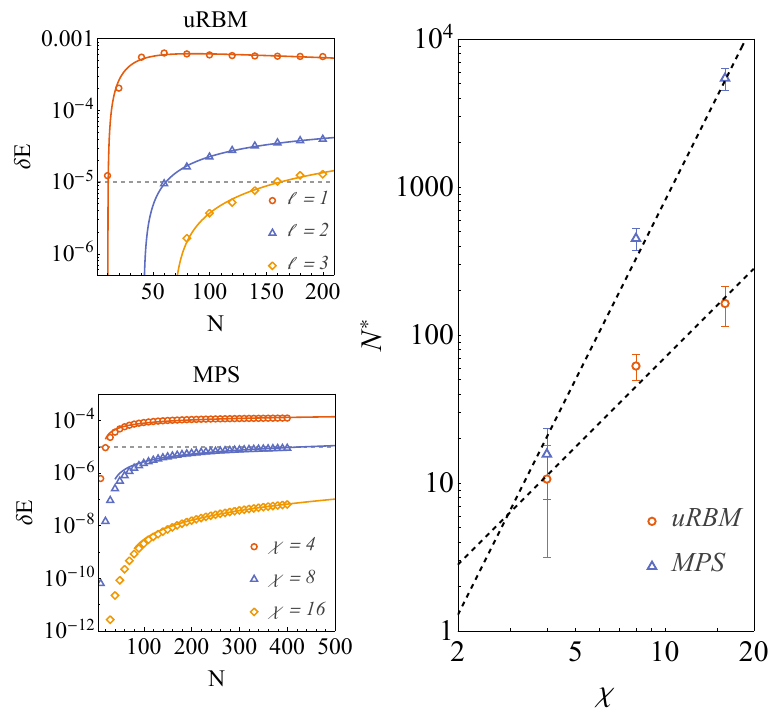
Figure 4: (left panels) Finite size scaling analysis of the relative error in the ground- state energy of the critical Ising chain for different many-body wave function ansatz (uRBM and MPS); the grey dashed lines correspond to the accuracy goal 10 − 5 . (right panel) Scaling of the largest system size N ∗ which can be described with an energy accuracy ≤ 10 − 5 for the two different ansätze. The black dashed lines are power-law fits as reported in the main